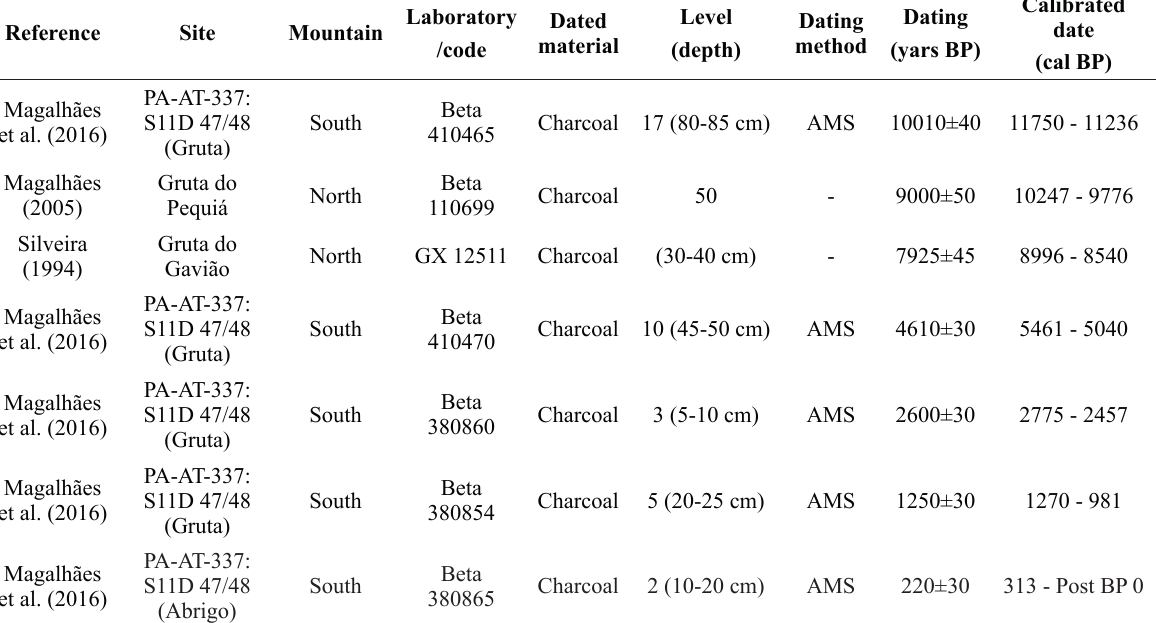
Dating site from Serras Norte and Sul de Carajás, calibrated in from program OxCal 4.2 (Bronk Ramsey 2009), adopting a probability level of 95% (2